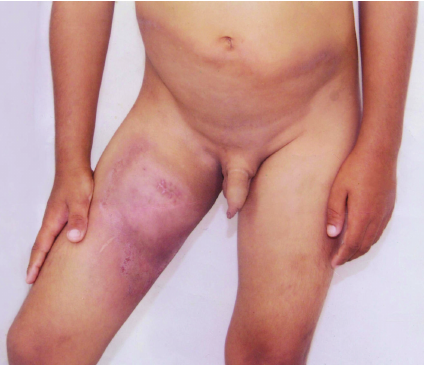
Figure 1: Extensive erythematous infiltrated plaque involving the abdomen and the right tight.